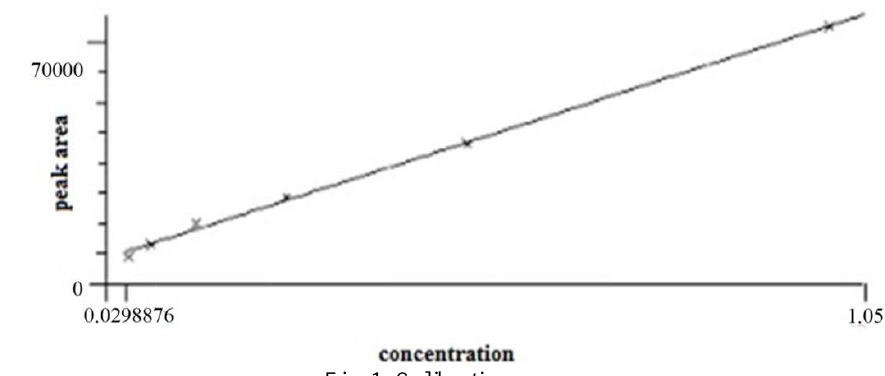
Fig. 1. Calibration